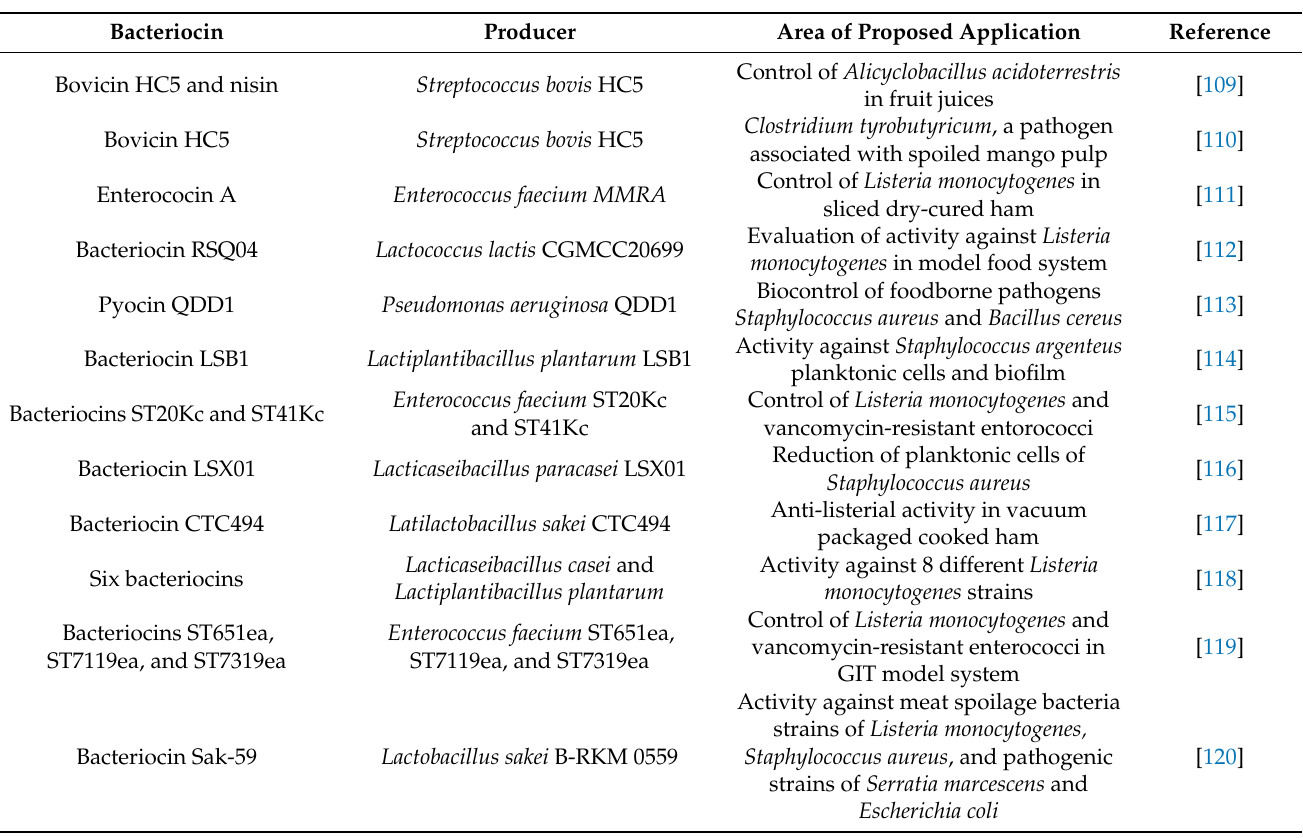
Table 1. Examples of some proposed food and feed-related applications for some of recently reported